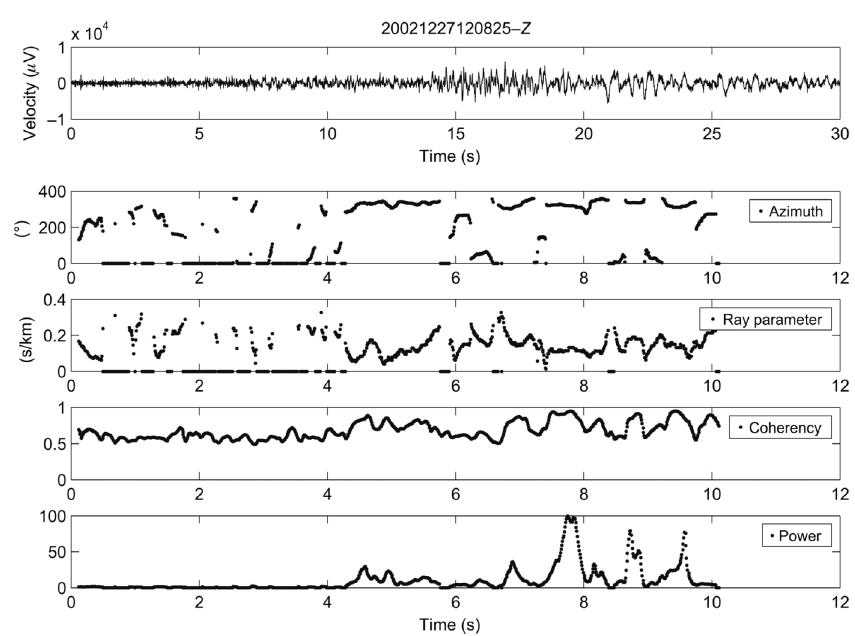
Fig. 10. Time behaviour of the propagation parameters for a M d = 2 event at 12:42 GMT on December 27, 2002, at an epicentral distance of about 80 km. From top to bottom, sample vertical-component seismogram, propaga- tion azimuth, ray parameter, multichannel coherency and power of the frequency-stacked slowness spectra. The P -wave arrival is marked by the sudden increase in both the slowness spectral power and coherency values about 4 s into the event. Table I. List of analysed